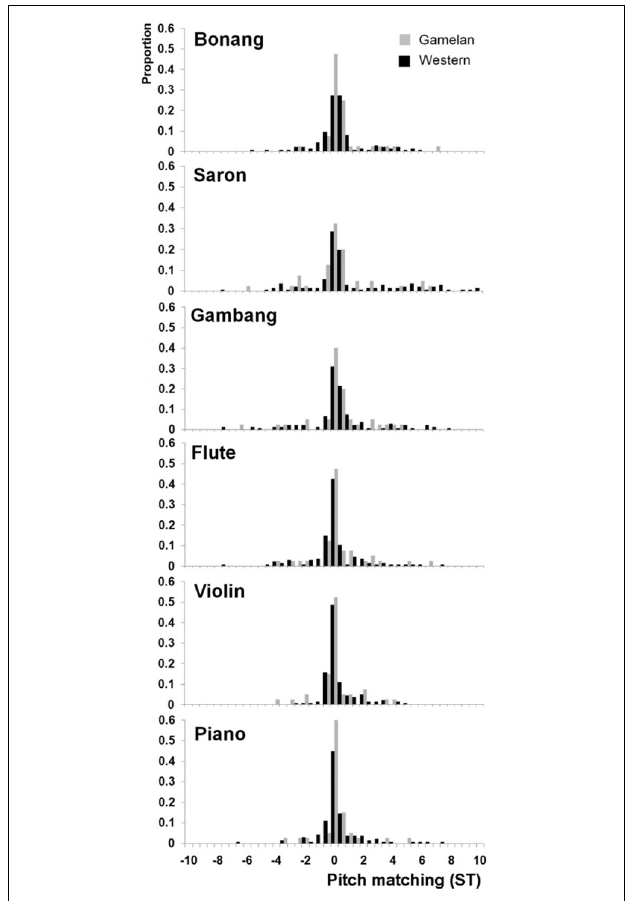
FIGURE 3 | Pitch-matching histograms for each instrument and musician group adjusted to the frequency of the first partial of each stimulus. ST = semitones.